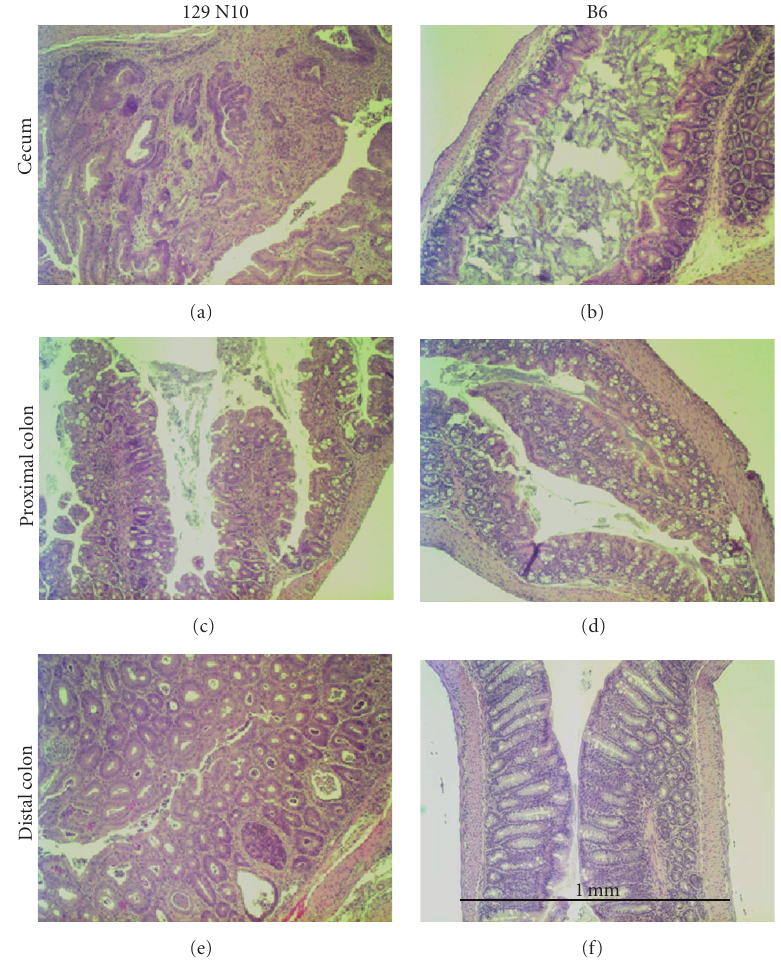
Figure 3: Representative histopathology in the colon of 129 N10 and B6 mice on AIN at 22 days of age. Slides were stained with hematoxylin and eosin. By 22 days of age, 90% of 129 N10 DKO mice have disease signs of diarrhea and many are lethargic. B6 DKO mice are without these signs. This is correlated with histopathology in the cecum and colons of these mice. 129 mice show inflammation and distortion of the cecum and distal colon with frequent crypt abscesses in the distal colon. The inflammation frequently skips the proximal colon (shown here). In severe cases, where lethargy has progressed to wasting, the proximal colon can be involved. The cecum and colon of B6 mice show mucin depletion and mild distortion due to apoptosis and